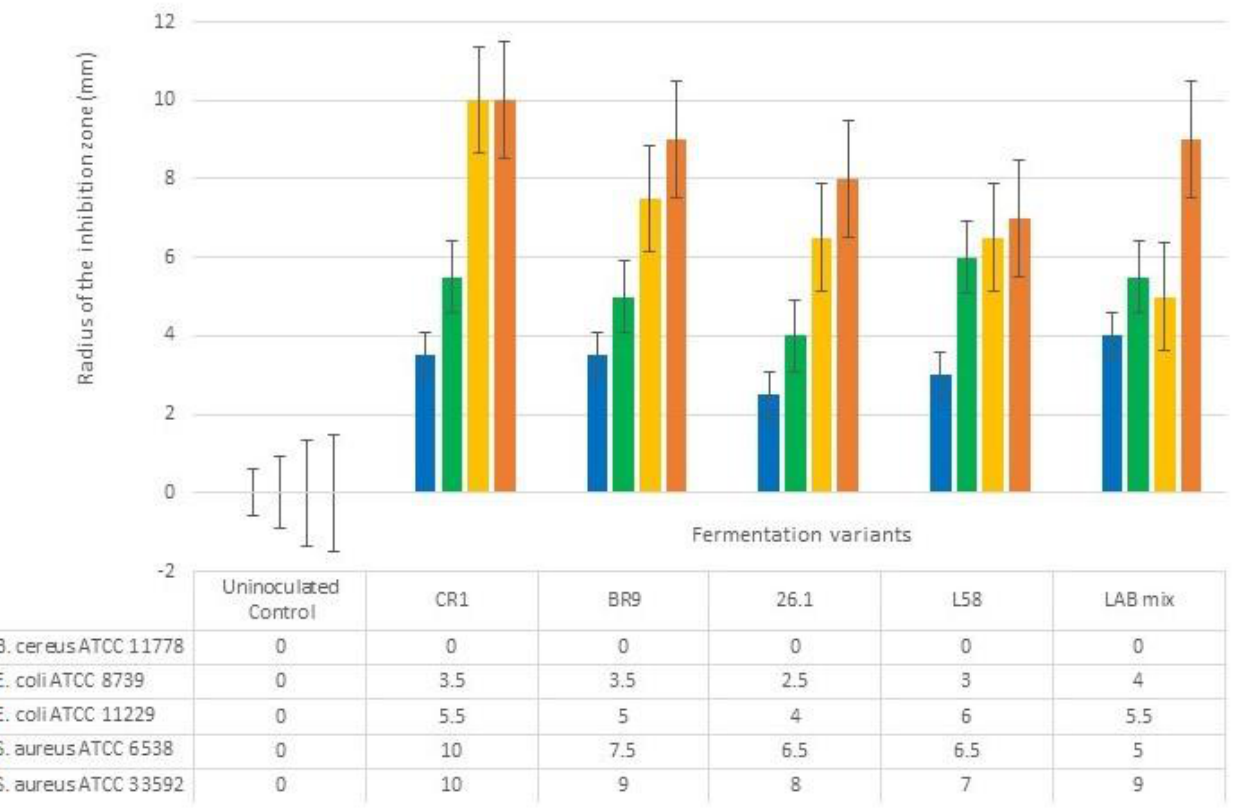
Figure 4. Antibacterial effect of fermented tomato juice. The error bars represent the standard error. Different letters indicate significant difference between fermented variants regarding their antibacterial activity against tested human pathogens.